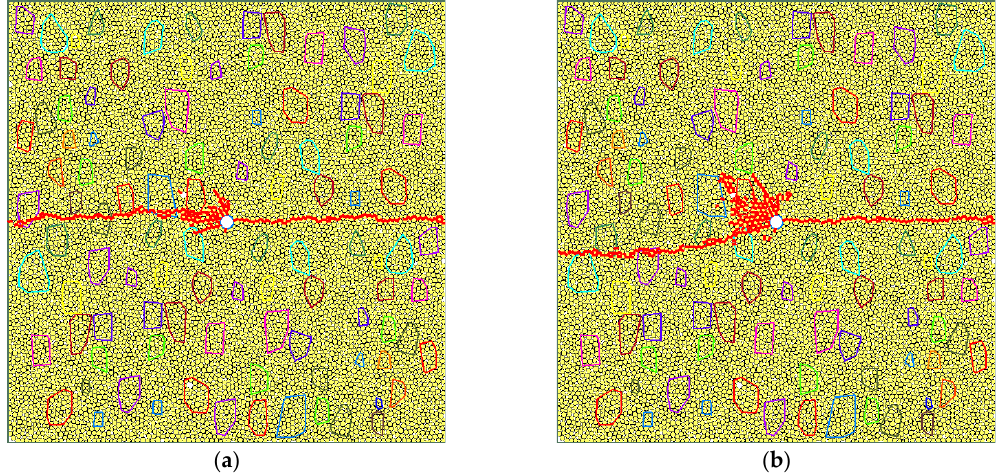
Figure 8. The fracture morphologies under different injection rates. ( a ) Injection rate is 2 × 10 − 4 m 3 /s. ( b ) Injection rate is 4 × 10 − 4 m 3 /s.